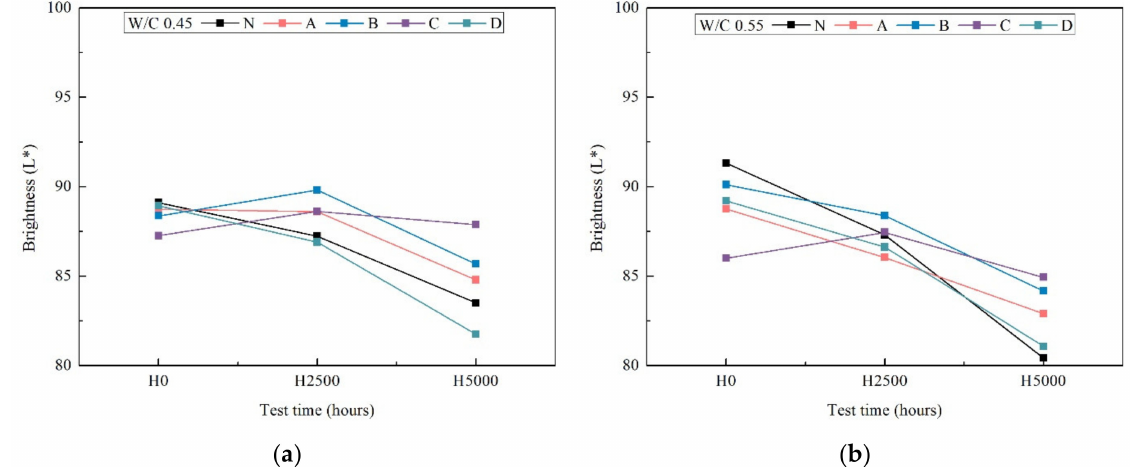
Figure 3. The brightness (L*) of color difference after accelerated aging test after 0 h, 2500 h and 5000 h weathering of w/c ratio 0.45 ( a ) and 0.55 ( b